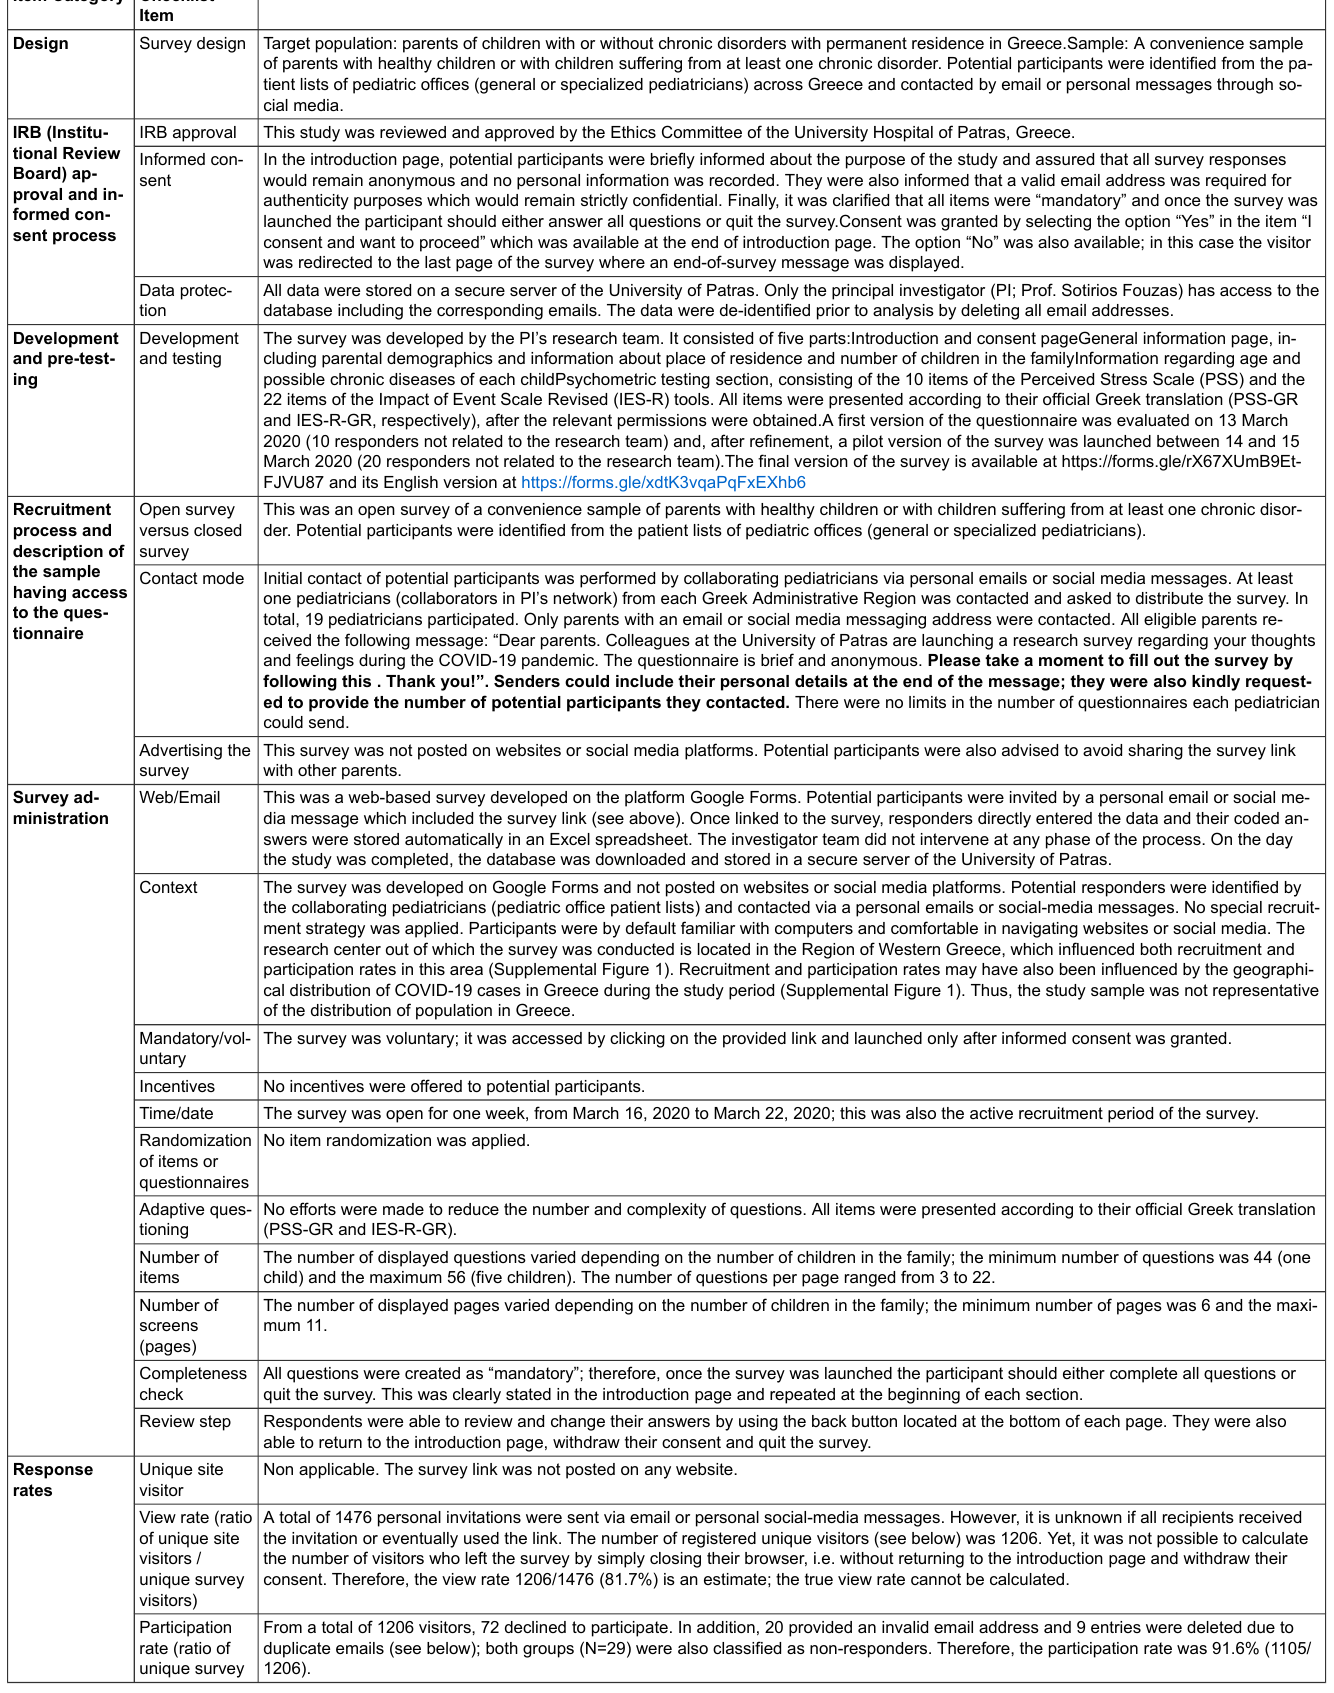
Table S1: Checklist for Reporting Results of Internet E-Surveys